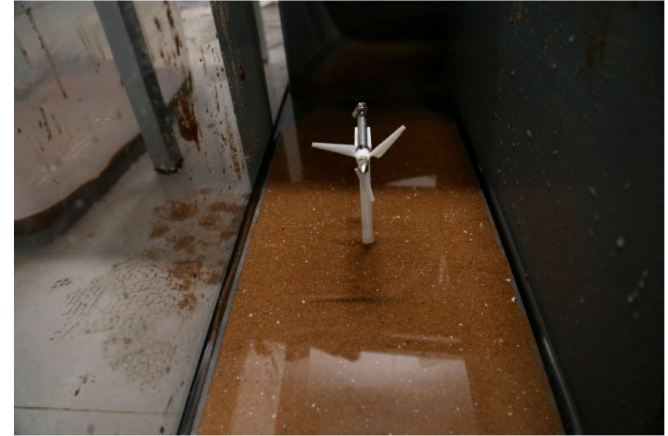
Figure 6. Recirculating flume in Marine Renewable Energy Laboratory, Tianjin University. (1: Plexiglass; 2: Propeller; 3: Laser range finder; 4: Guide bend; 5: Frame structure; 6: Separator; 7: Flume; 8: Perforated distribution plate; 9: Sand box).